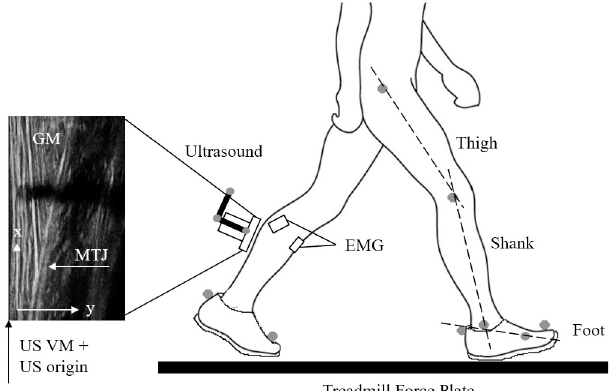
Fig 1. Experimental set-up and illustration of ultrasound (US) configuration for calculating GM MTJ coordinates. Grey dots on lower body represent placement of motion capture markers; ultrasound graphic includes 3-marker rigid body from which a virtual marker (VM) was constructed at the edge of scanning interface. The VM corresponded with the origin of the US reference frame and was used to transform the 2D coordinates of the MTJ to the motion capture’s 3D coordinate system, from which tendon length was